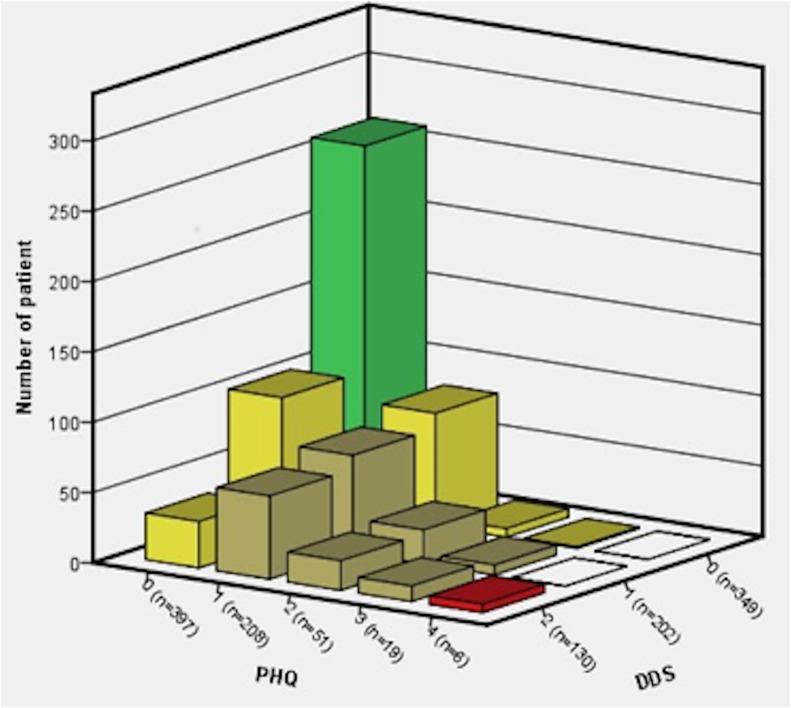
Distribution of depression within diabetes-related distress categories, n = 684.PHQ = Patient Health Questionnaire 9 items, depression severity: 0 (none = 0–4), 1 (mild = 5–9), 2 (moderate = 10–14), 3 (moderately severe = 15–19) & 4 (severe = 20–27). DDS = Diabetes Distress Scale 17 items, categories: 0 (no distress), 1(moderate distress) and 2 (high distress worthy of clinical attention)